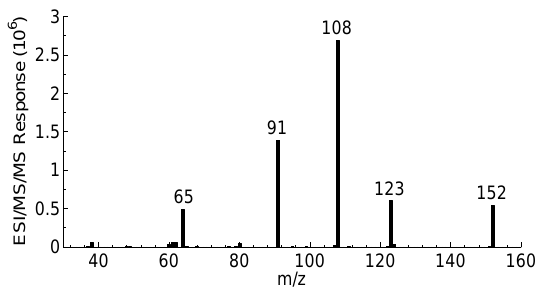
Figure 1. ESI-MS/MS product scan of vanillic acid using 30eV collision energy.